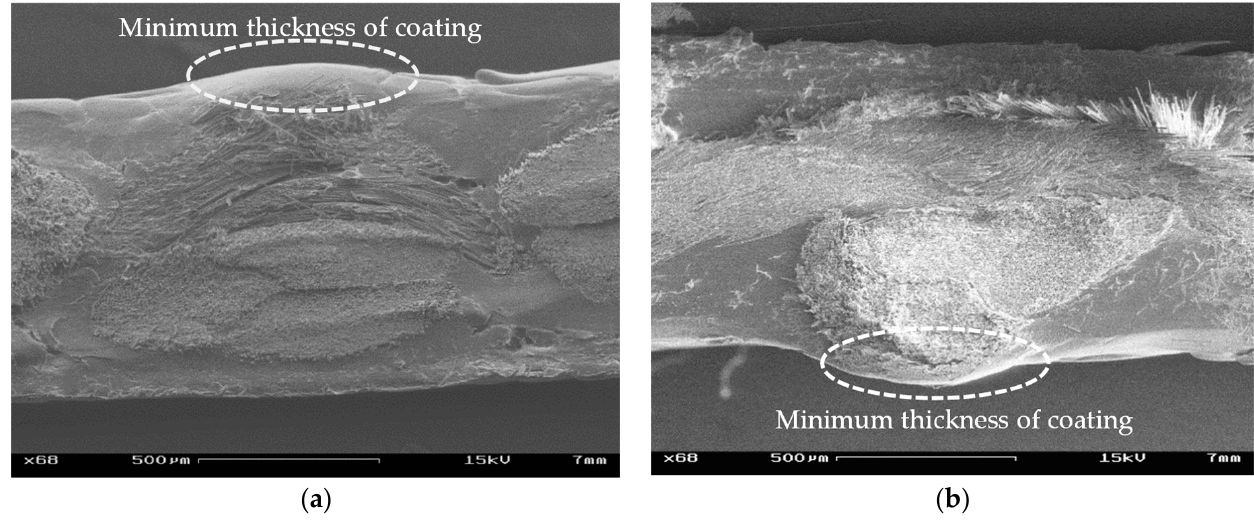
Figure 2. Cross-section view of coating irregularities, glass-PTFE type IV, first batch (see Table 3): ( a ) cut through warp yarns and ( b ) cut through weft yarns; images by scanning electron microscope (see Section 2.1.3).